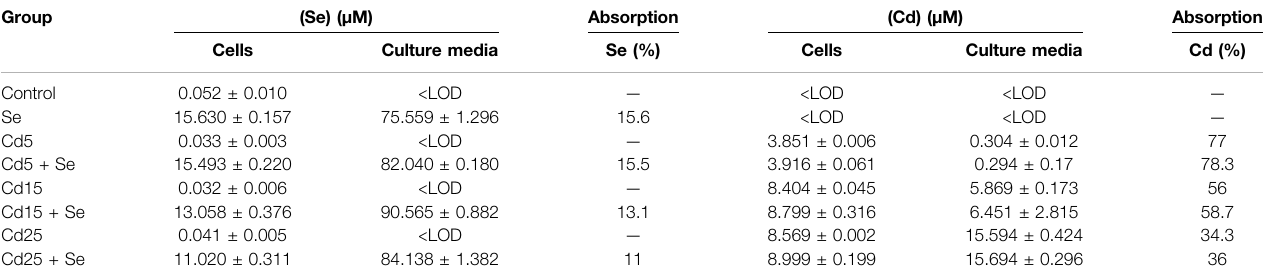
TABLE 1 | Total Se and Cd contents (µM) in cell pellets and culture media expressed as mean ± standard deviation ( n = 3) and Cd and Se absorption percentage (%).